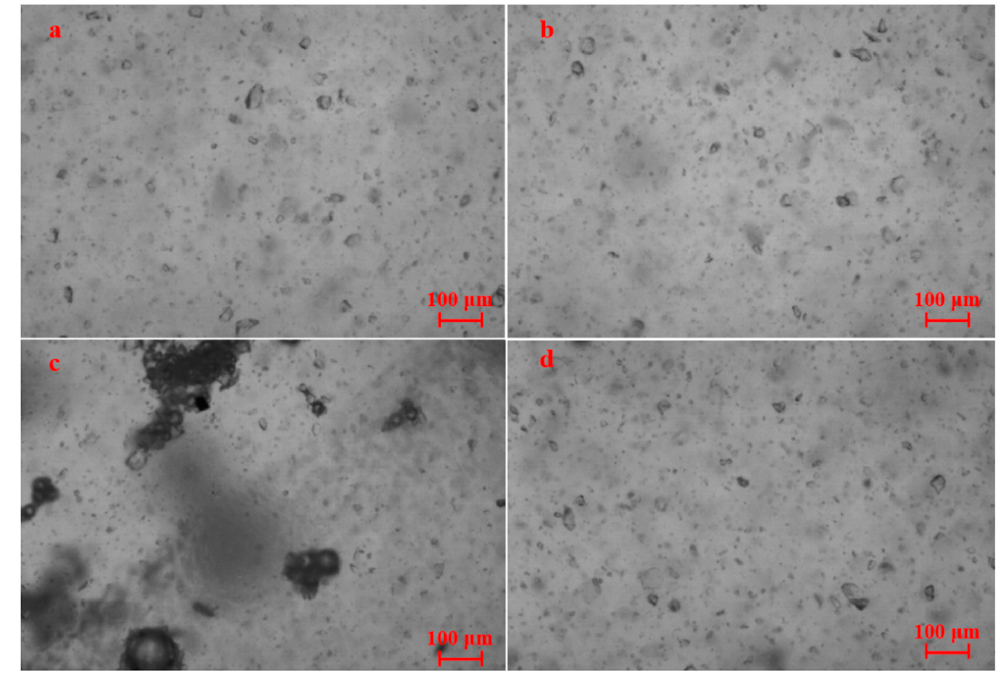
Figure 16. Quartz aggregates under different conditions conditions ( a ) raw quartz ore; ( b ) quartz + 1 × 10 − 5 M CTAB; ( c ) quartz + 1 × 10 − 5 M CTAB + BMNBs with the ageing time of 0 min; ( d ) quartz + 1 × 10 − 5 M CTAB + BMNBs with ageing time > 3 min).